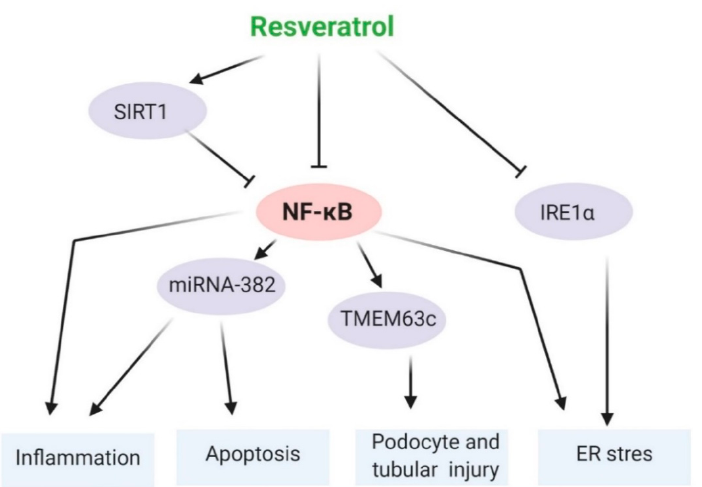
Figure 4. Resveratrol-inhibited NF- κ B is associated with the inhibition of various mechanisms of age-related pathologies. Resveratrol inhibits NF- κ B; thus, it may reduce kidney inflammation, tubular apoptosis and injury, podocyte apoptosis and damage, and ER stress. It also suppresses ER stress through inhibition of the IRE1 α pathway. All of these pathways are involved in the higher potency of resveratrol against the NF- κ B-associated aging process in kidneys. Membrane protein 63c, TMEM63c. Arrow means activation, and ‘T’ arrow means inhibition.